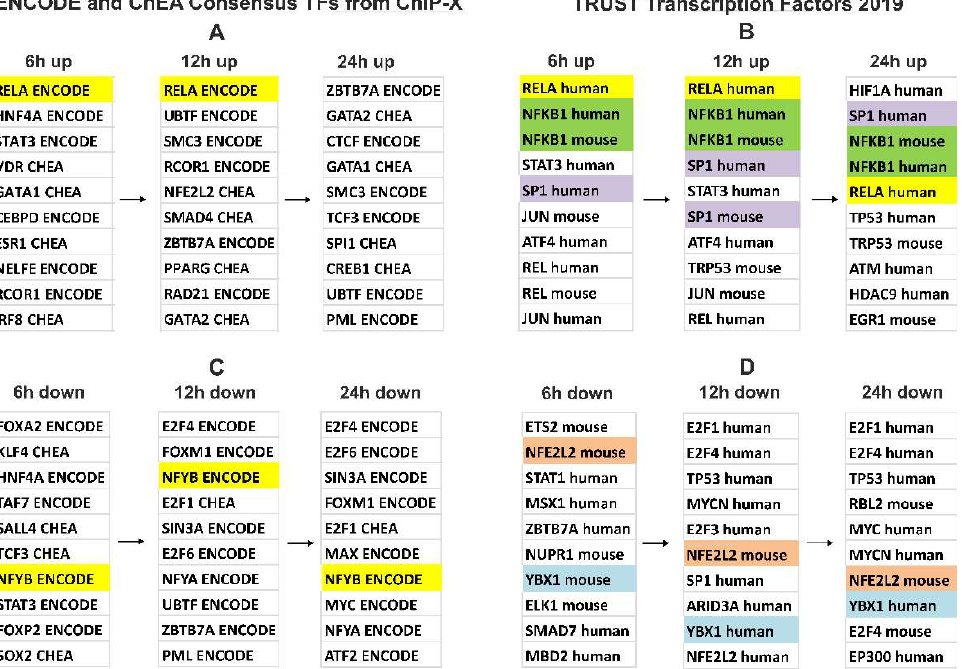
Figure 4. Transcription factors controlling gene expression changes in A549 cells incubated with human blood EVs according to the gene set enrichment analysis with Enrichr. ( A , B )—factors involved in the control of upregulated genes. ( C , D )—factors involved in the control of downregulated genes. Top 10 Enrichr records sorted by ascending p -value (Supplementary Tables S7–S12). Common top transcription factors for the differentially expressed gene sets (6, 12, 24 h; up or down) are highlighted in color. Table 4. Representatives of genes whose mRNA levels were differentially expressed after 6 h as well as after 12 and 24 h of incubation of A549 cells with EVs.